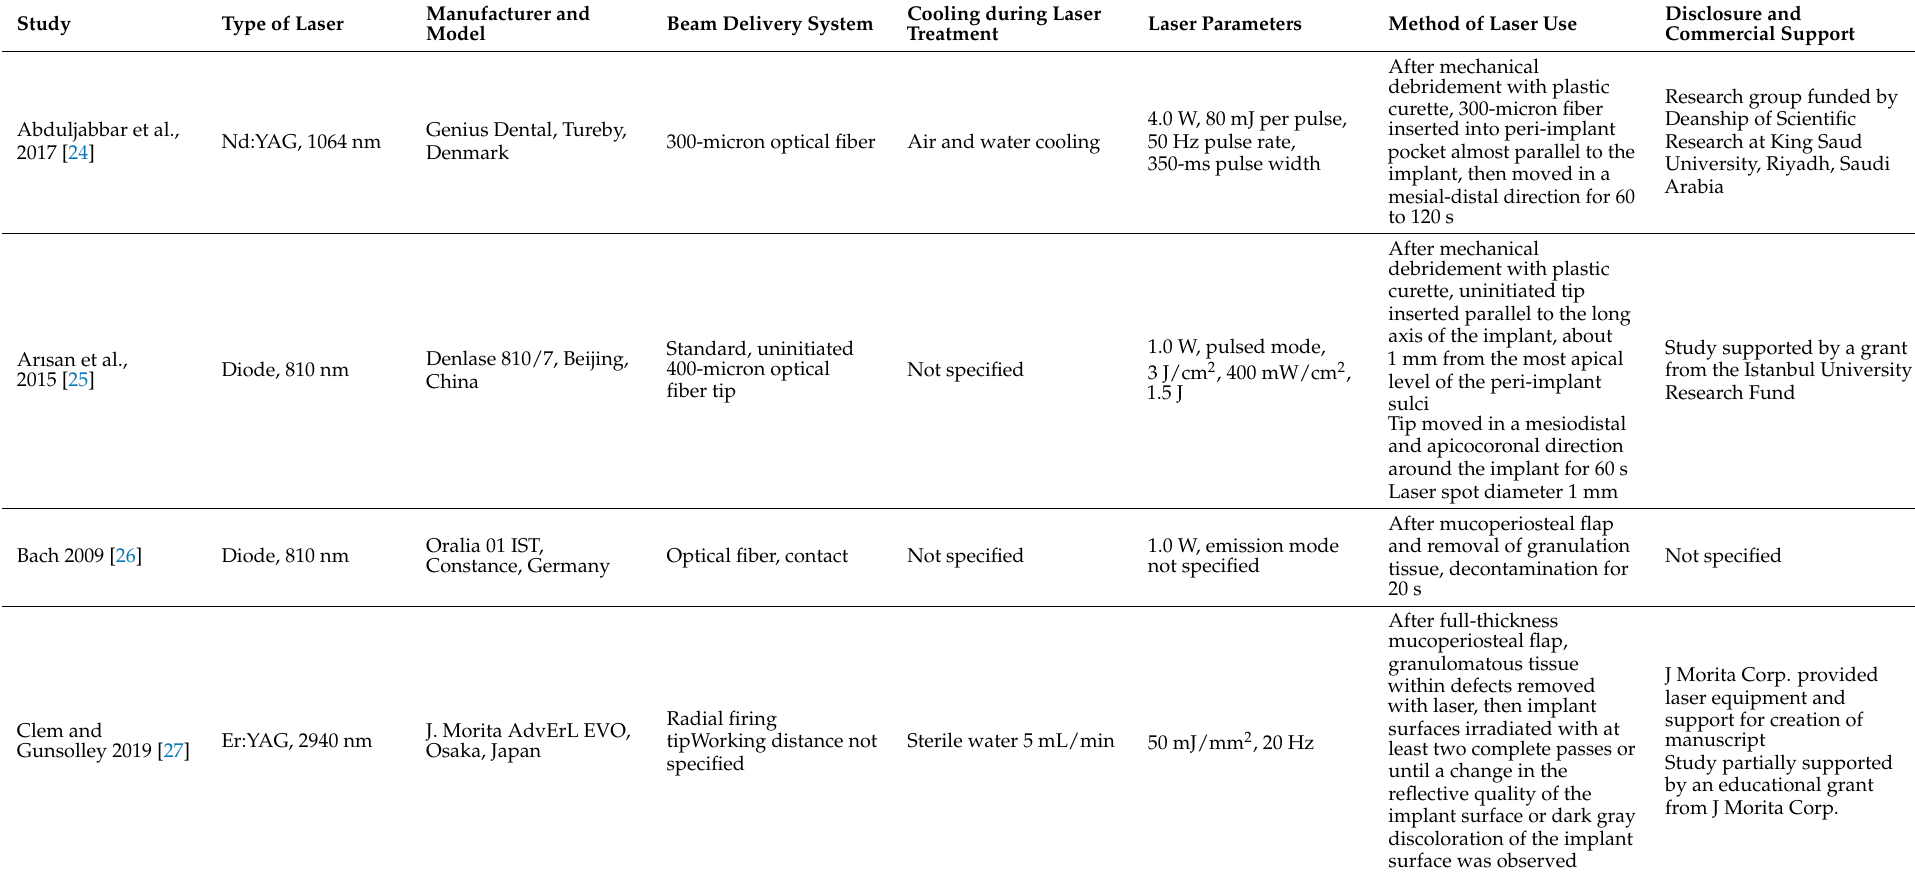
Table 3. Laser details and